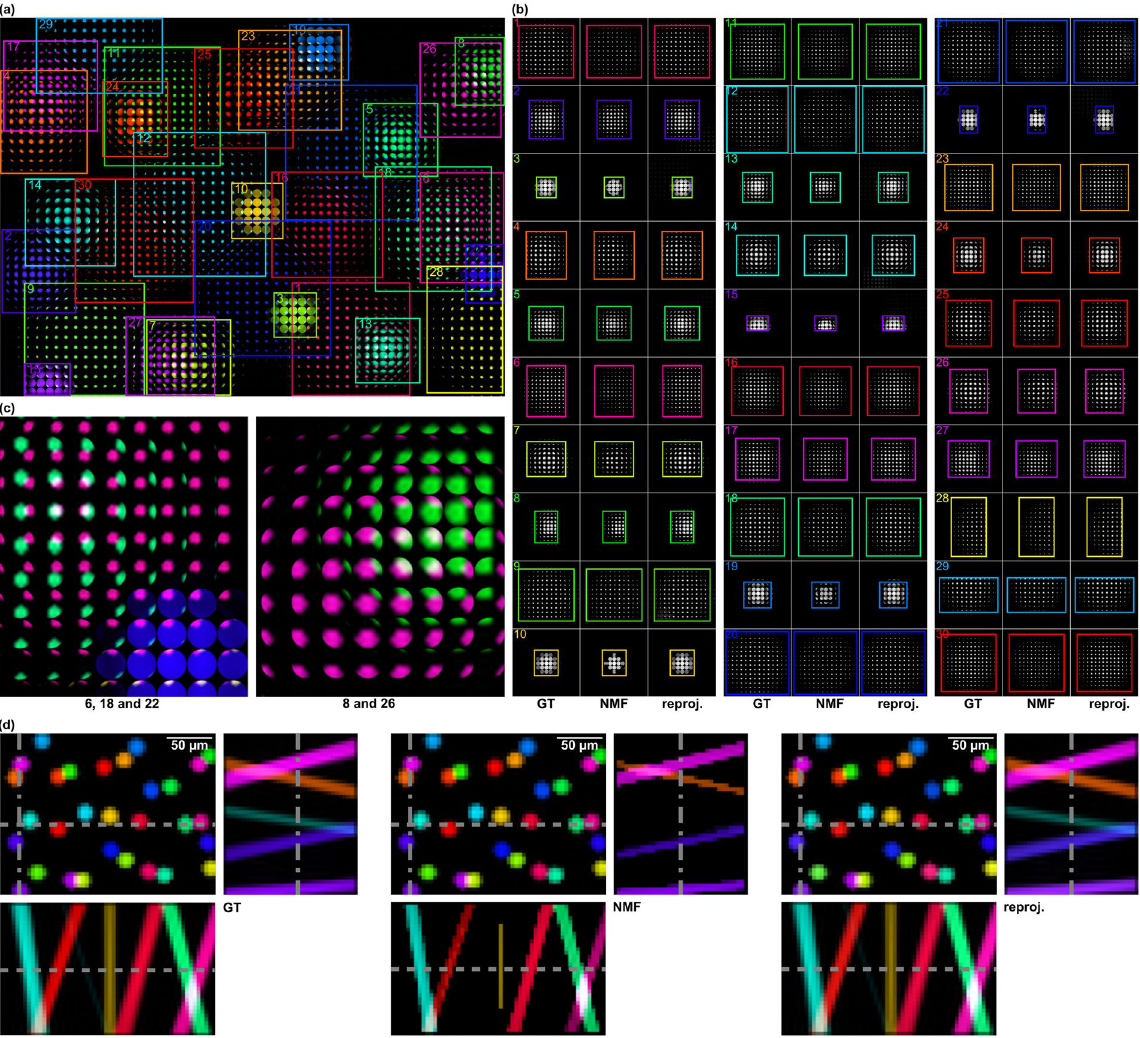
Figure 3. Simulated CVLE results (ground truth; after NMF; after reprojecting factorized signatures): ( a ) MLA image of color-coded particle light fields after reprojecting their factorized signatures. ( b ) Close-ups of each particle signature. ( c ) Close-ups of overlapping signatures in ( a ). ( d ) Center light-field views with corresponding space-angle (epi) slices. Space-angle representation along dashed lines in center view indicates correct handling of occlusion cases (crossings of rays). The ACD between ground truth and final results (reprojected factorized signatures) is 0.0033. Simulated results are also shown in the supplementary